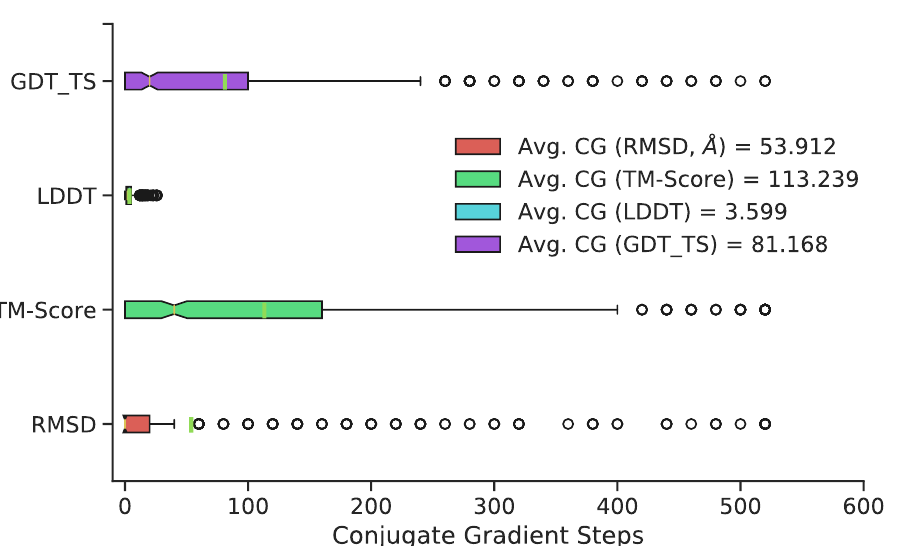
Figure 4. Distribution of the optimal number of CG steps for structure refinement, by metric, with green vertical lines representing means, and notches representing medians. Although exact optima vary by structure and metric, 50–100 steps are sufficient to provide good performance on most structures; extensive refinement beyond this point is rarely beneficial.